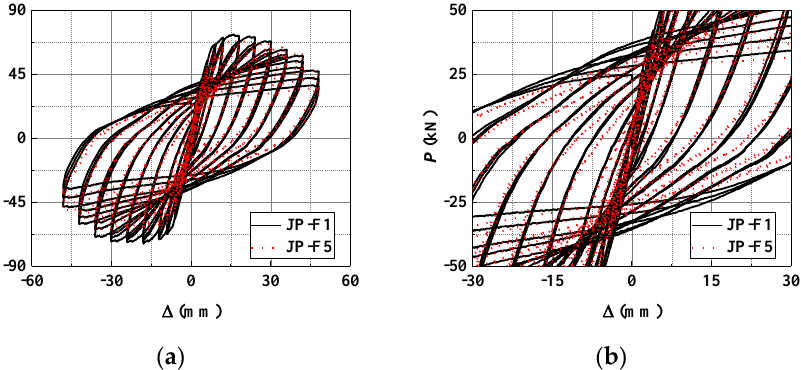
Figure 21. Hysteresis curves of the specimens with 25 and 125 cycles. ( a ) Comparison of JP-F1 and JP-F5 curves. ( b ) Locally enlarged view.